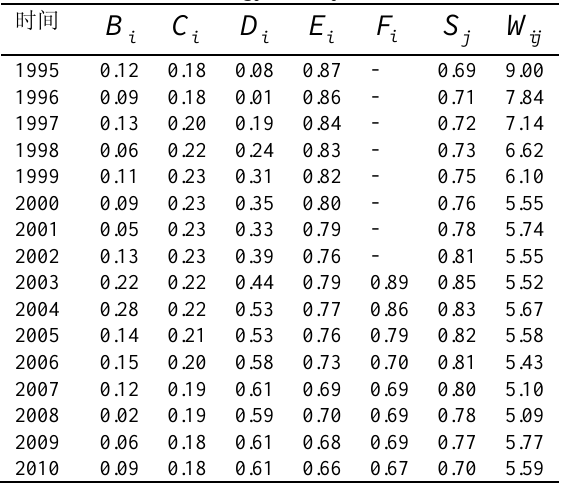
Tab.1 Geo-oil energy security evaluation data